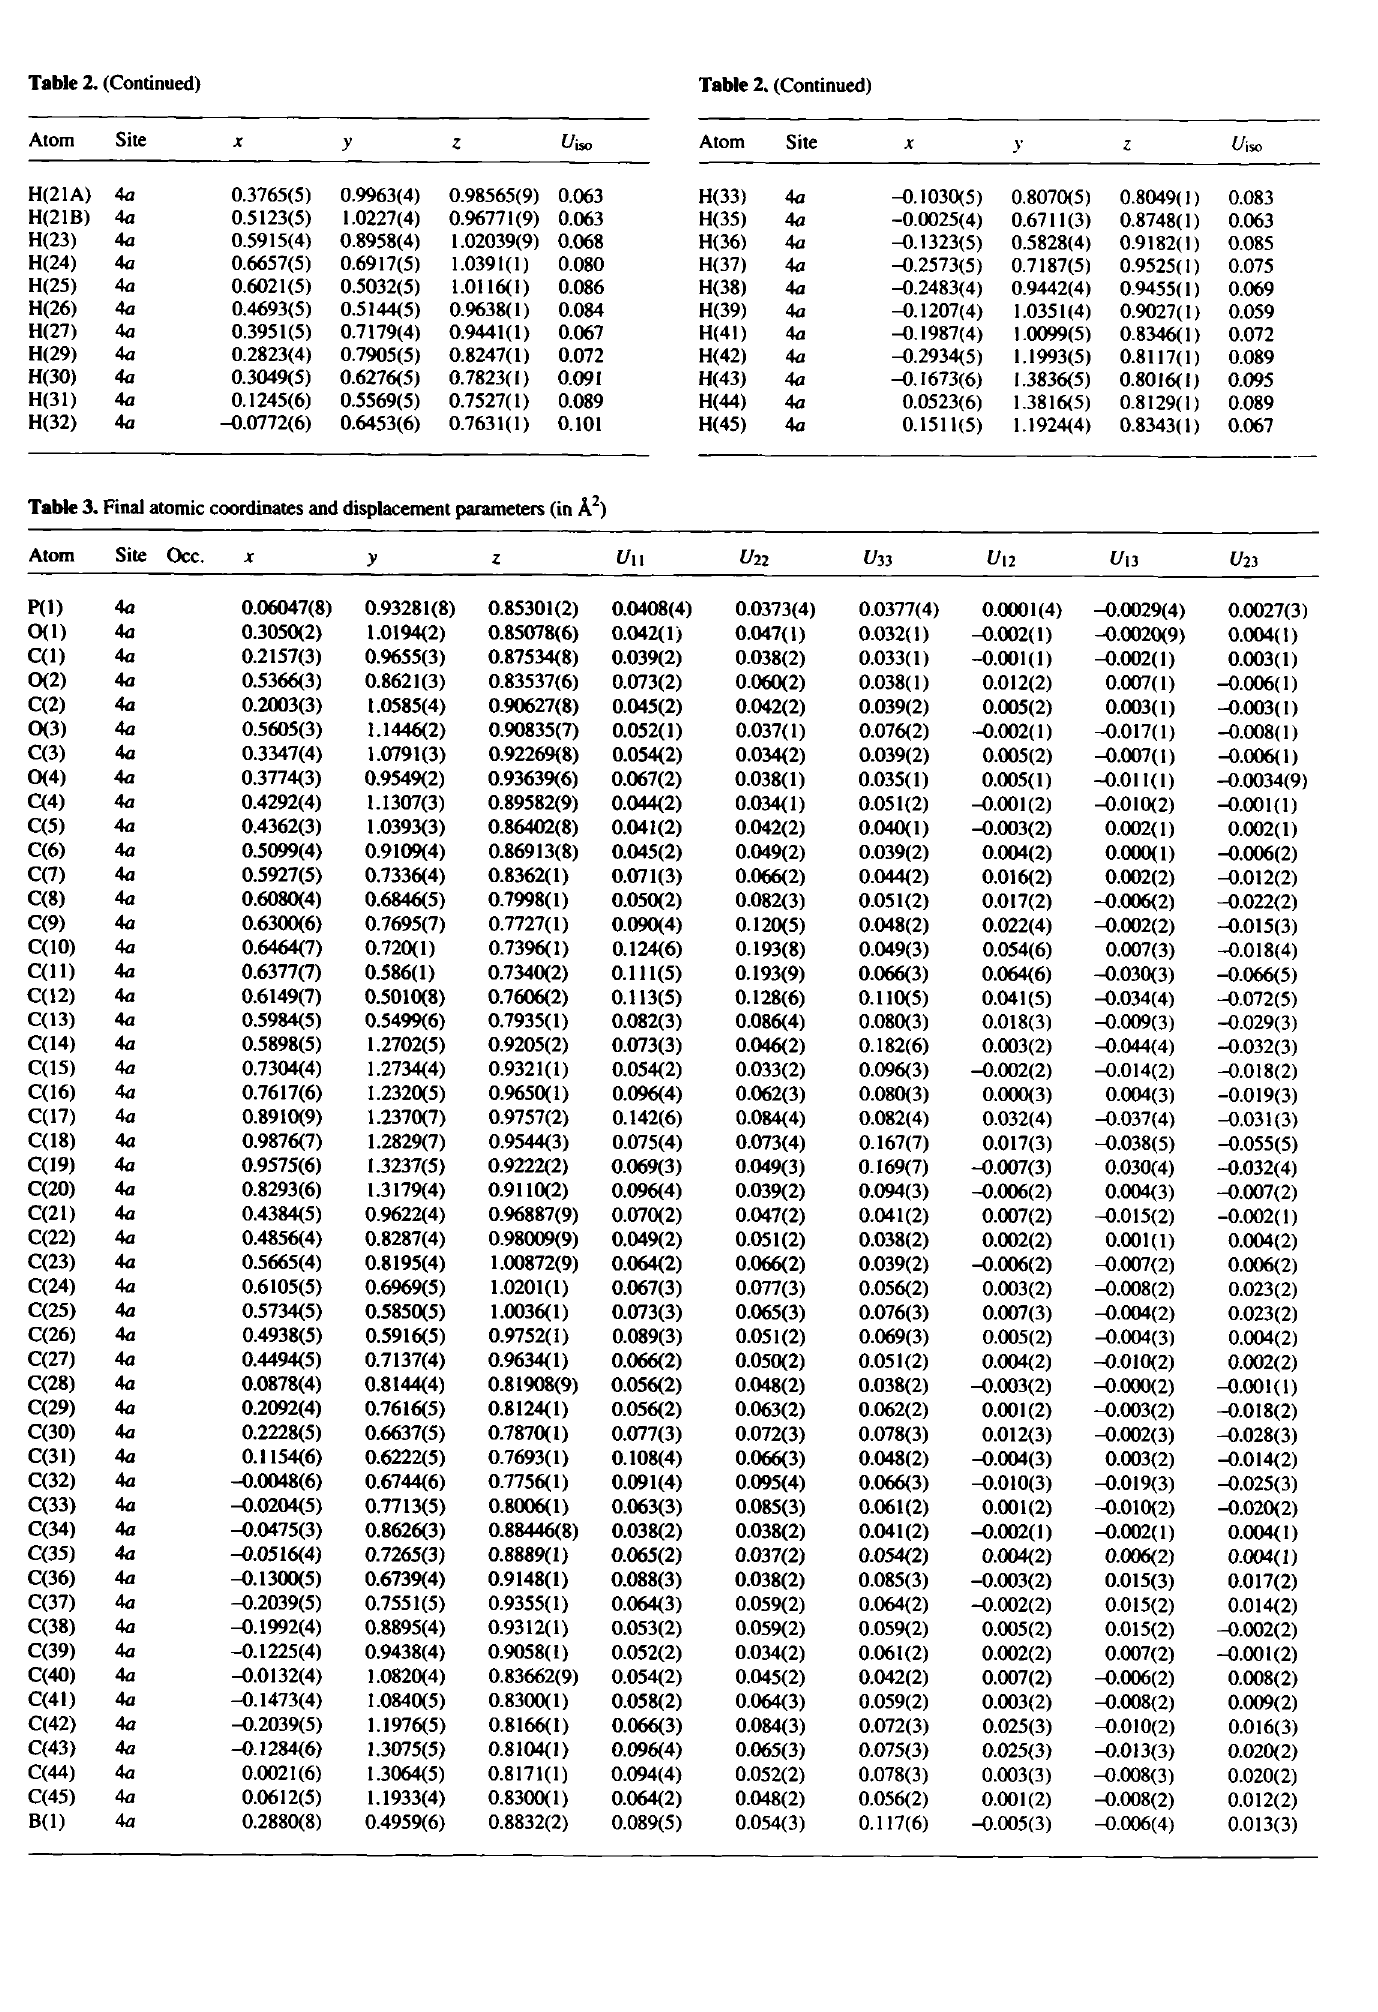
Table 3. Final atomic cooidinates and displacement parameters (in λ^) Atom Site